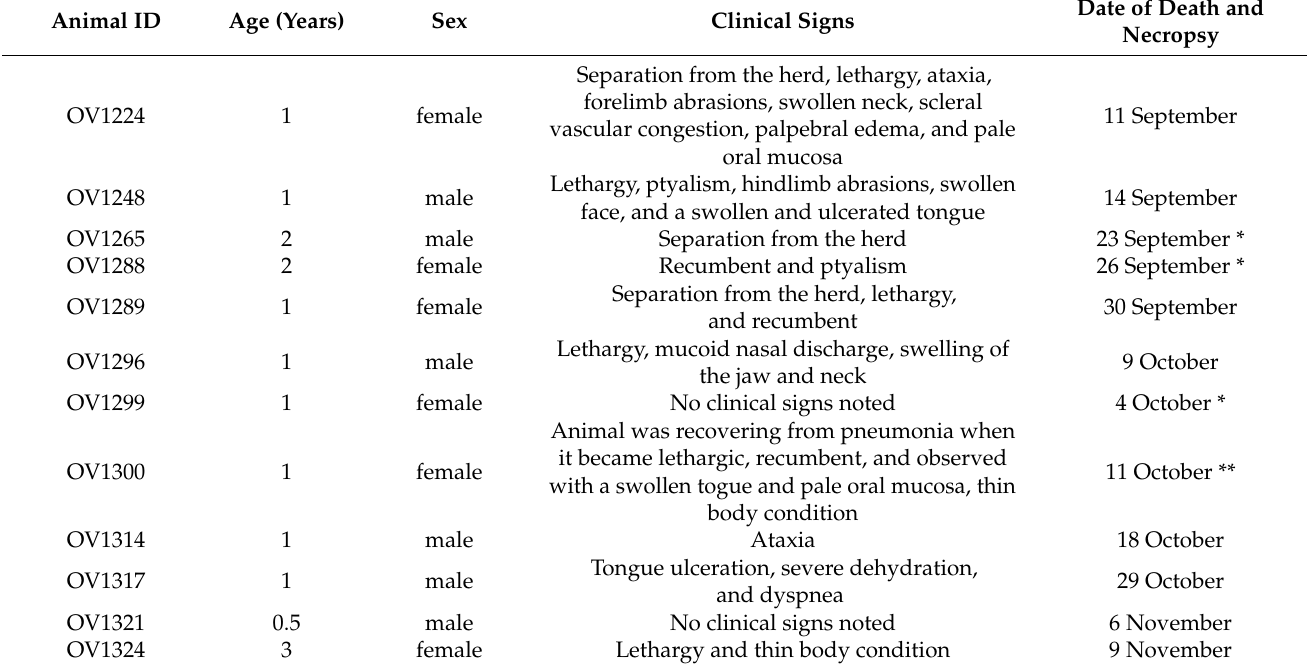
Table 1. Age, sex, clinical signs, date of death, and date of necropsy of 12 farmed white-tailed deer, Florida, U.S in